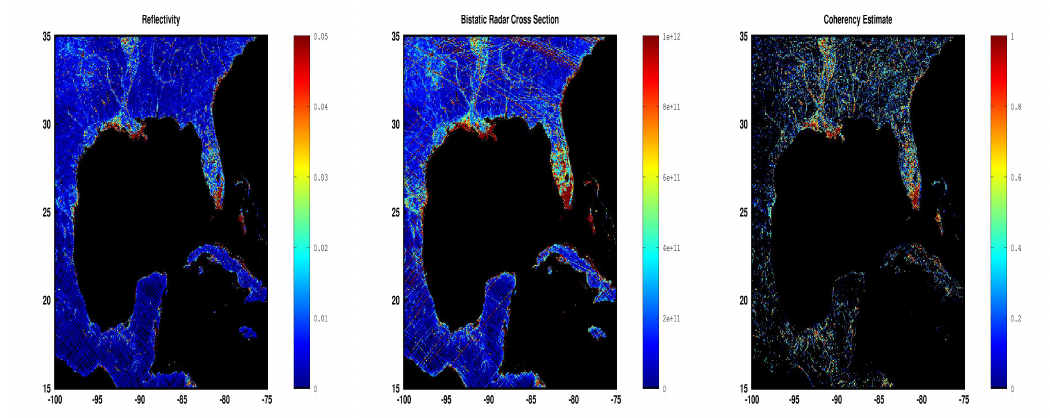
Figure 6. ( left ) Mean surface reflectivity from 12-days of CYGNSS observations. (middle) Mean surface peak bistatic radar cross section (BRCS) over the same 12-days of CYGNSS observations. ( right ) Estimated mean reflected signal coherency estimate over same 12-day interval (1 = coherent, 0 = non-coherent) for the Indian Peninsula and the Gulf of Mexico